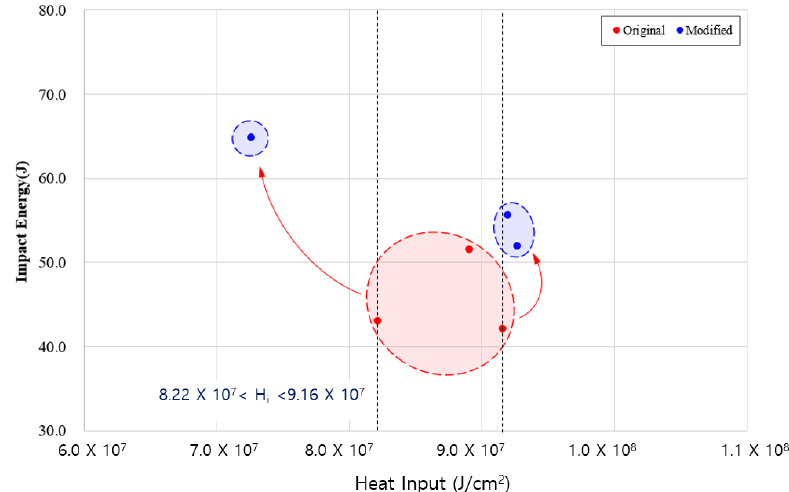
Figure 11. Brittle fracture behavior distributions using modified input parameters.